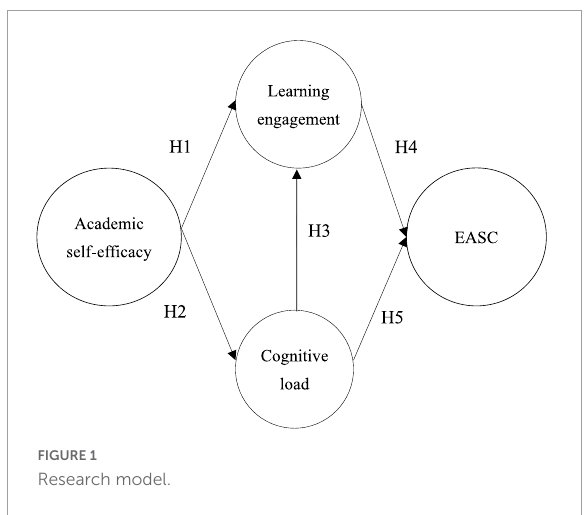
FIGURE1 Research